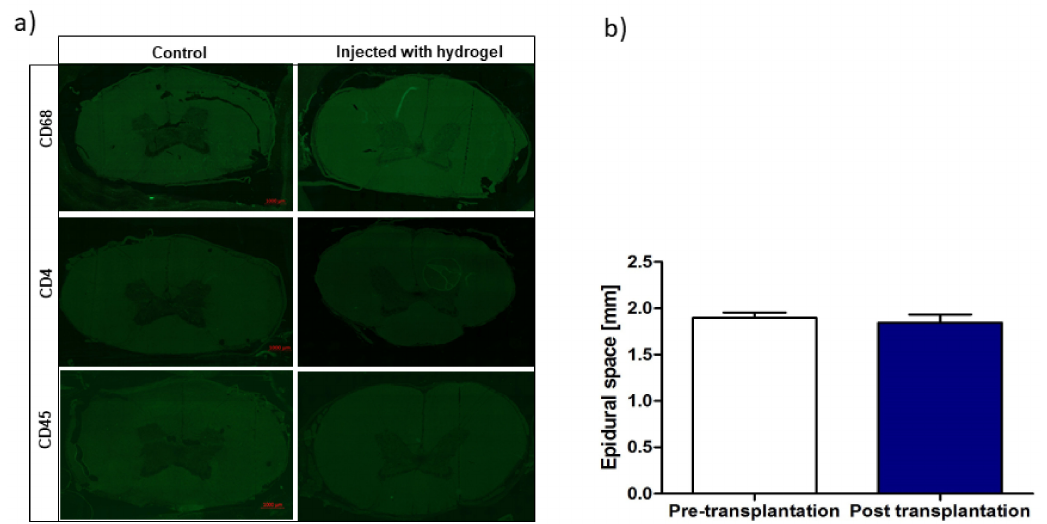
Figure 5. Safety of the LVM hydrogel intrathecal transplantation. ( a ) Immunofluorescence stainings of CD4, CD68, CD45 of the porcine spinal cords in the area when the hydrogel was injected. ( b ) Evaluation of intrathecal space dimensions visible on the MRI before versus